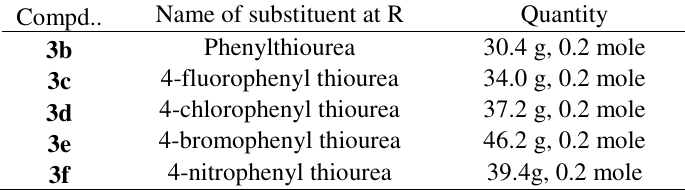
Table 1. Quantities of different thiourea